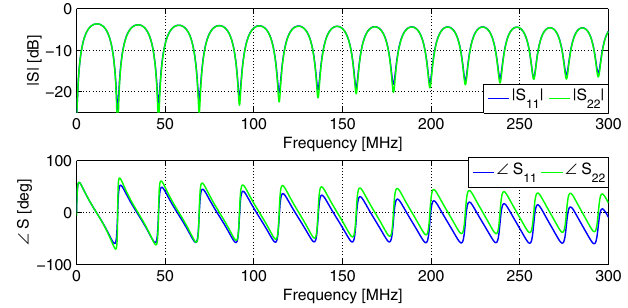
FIG. 16. Modulus and phase of S 11 meas and S 22 meas .